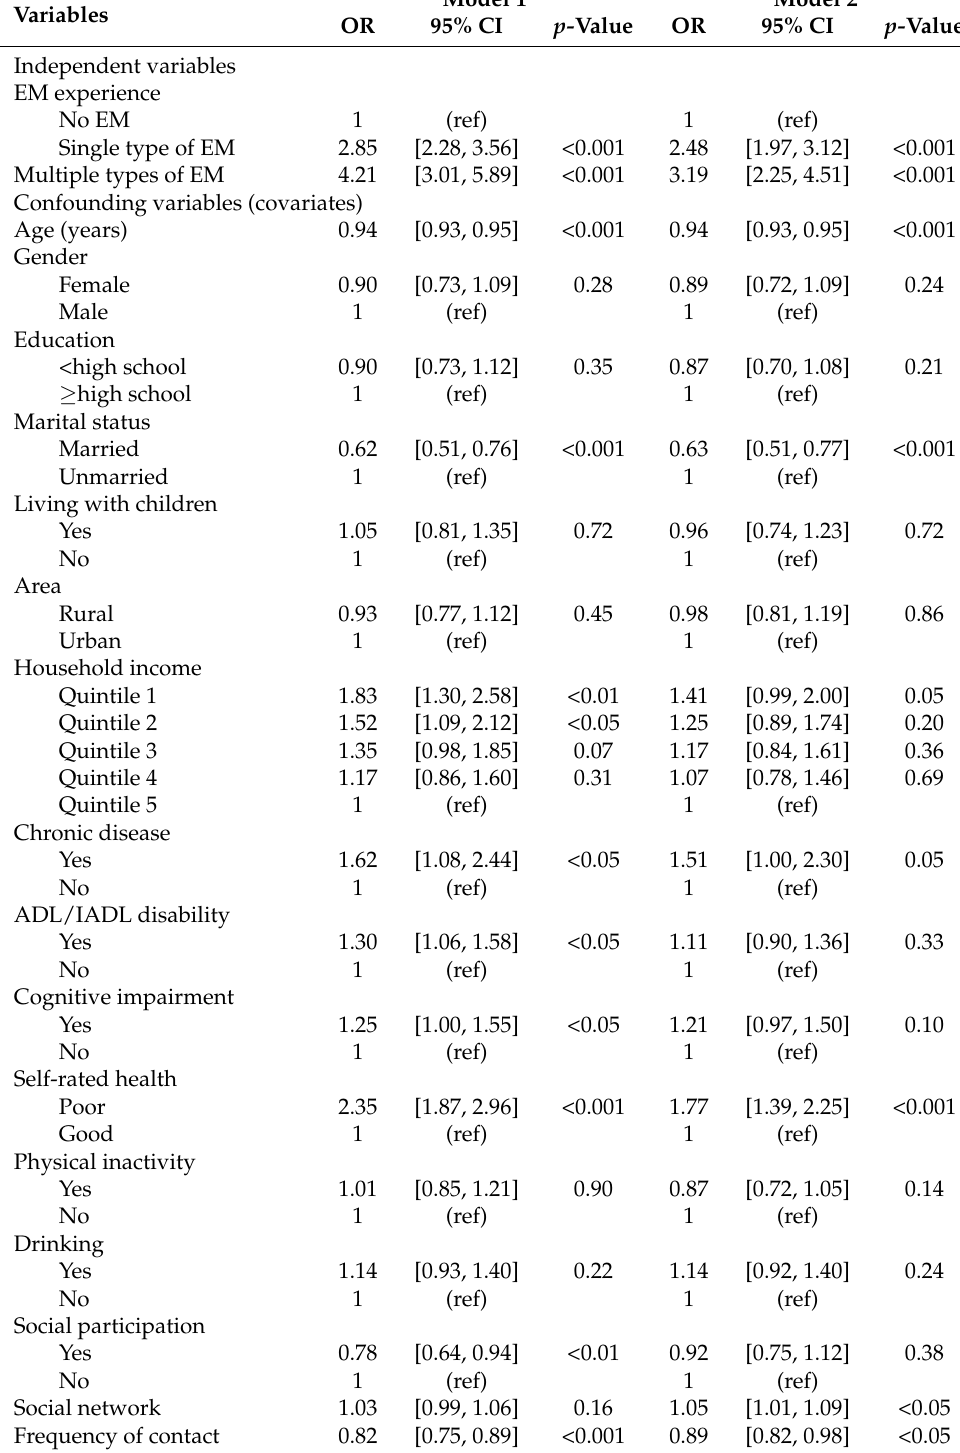
Table 3. Odds ratio of suicidal ideation by elder mistreatment experience